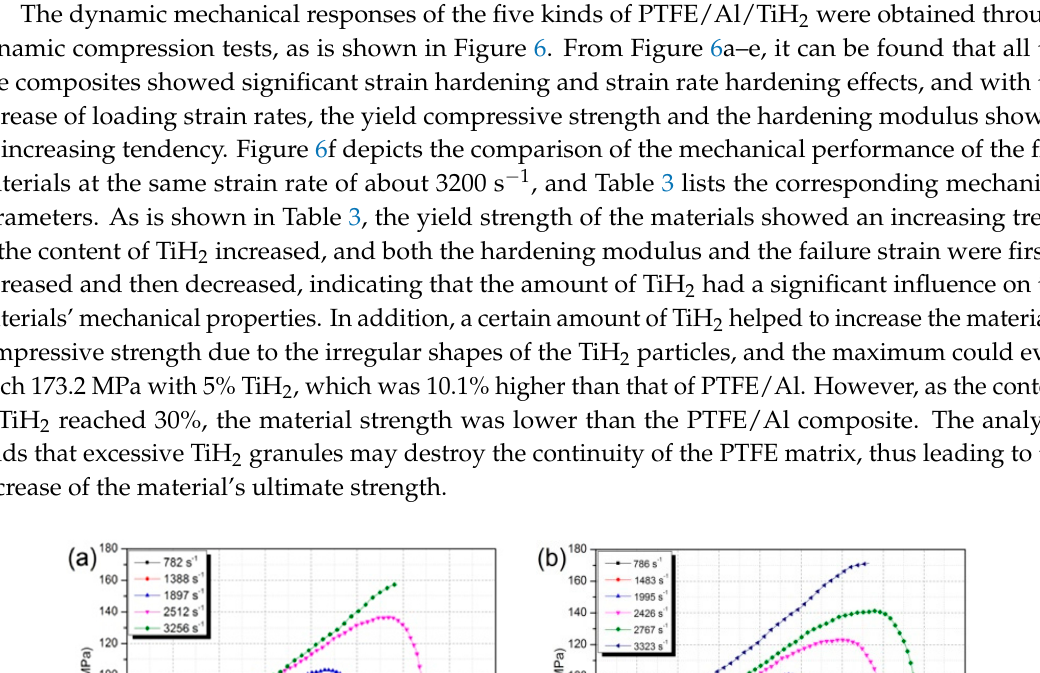
Figure 5. X-ray diffraction (XRD) pattern of the reaction residues in oxygen of type B composite.